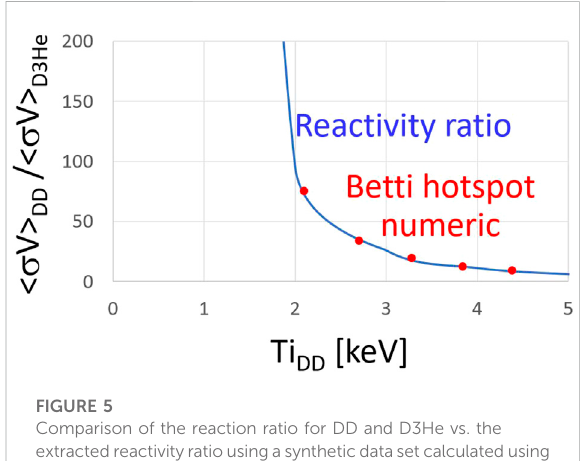
FIGURE 5 Comparison of the reaction ratio for DD and D3He vs. the extractedreactivityratiousingasyntheticdatasetcalculatedusing a Betti 1D hotspot pro fi le [32].